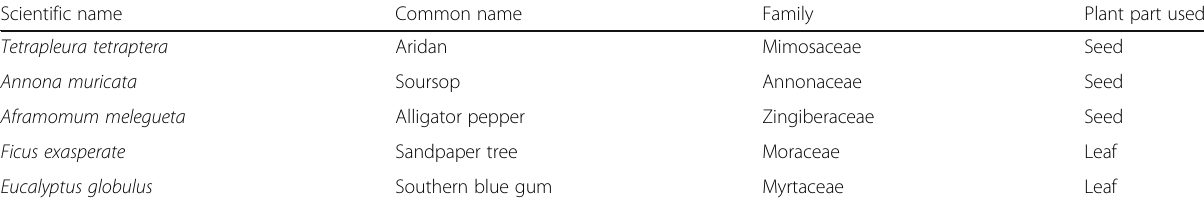
Table 1 Plant essential oils evaluated for insecticidal properties against Callosobruchus